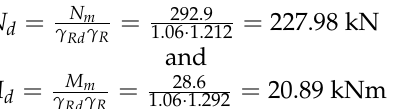
Table 2. Descriptive statistical parameters of the experimental results of the considered test series C45/55 without considering sample size aspects.